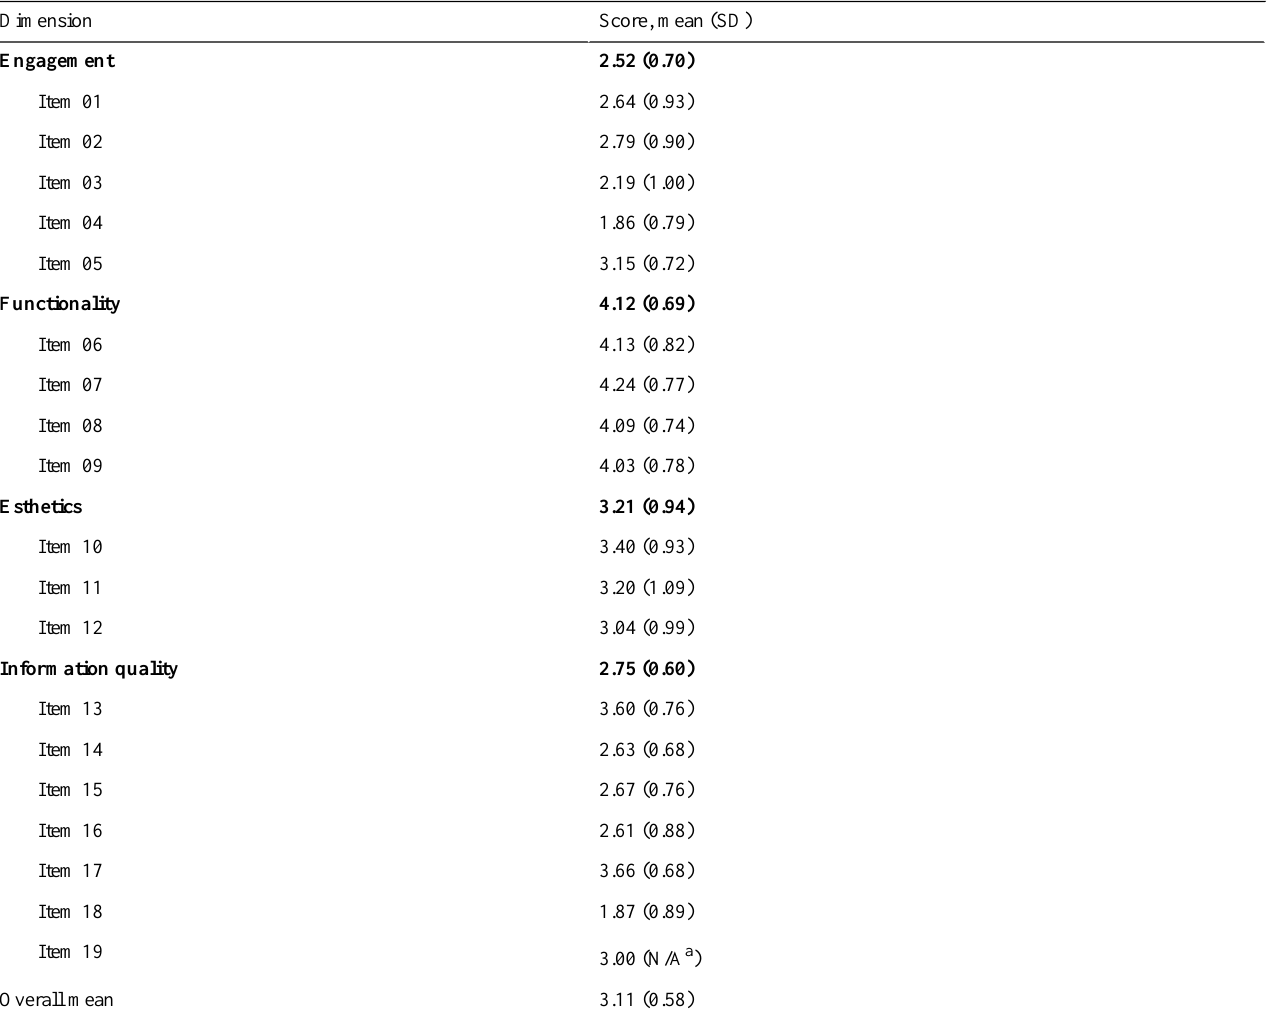
Table 1. Summary of item and scale scores for the German version of the Mobile App Rating